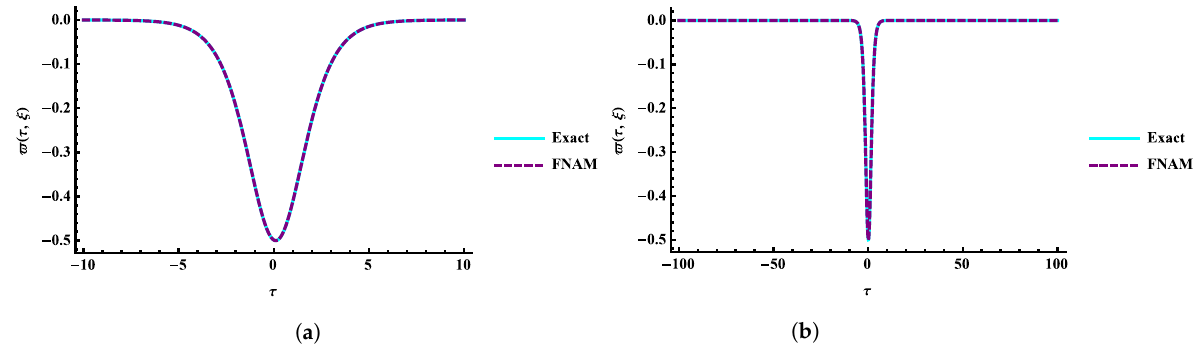
Figure 16. Comparison between the exact and numerical solutions by using FNAM